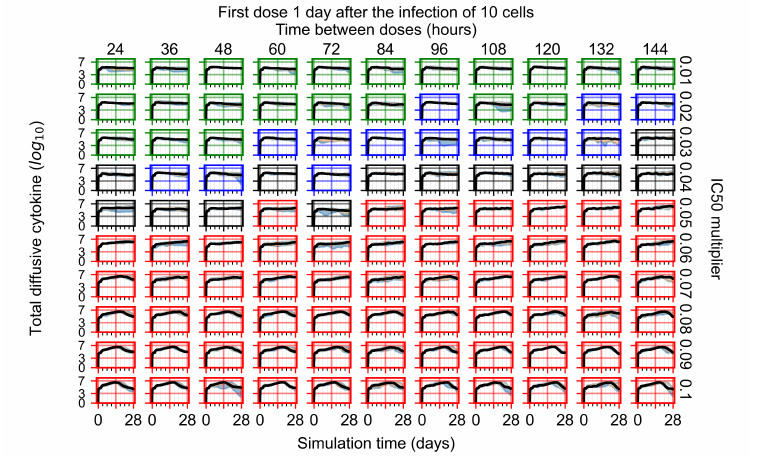
Figure A96. Total diffusive virus produced (AUC), Y axis in log scale, and exponent values as tick marks.